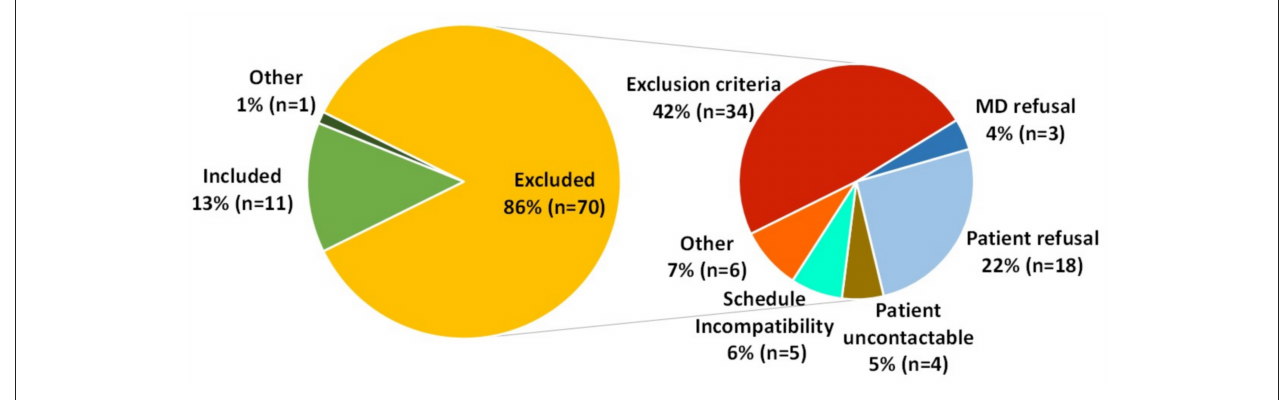
FIGURE 1 | Details of the patient inclusion and exclusion during the